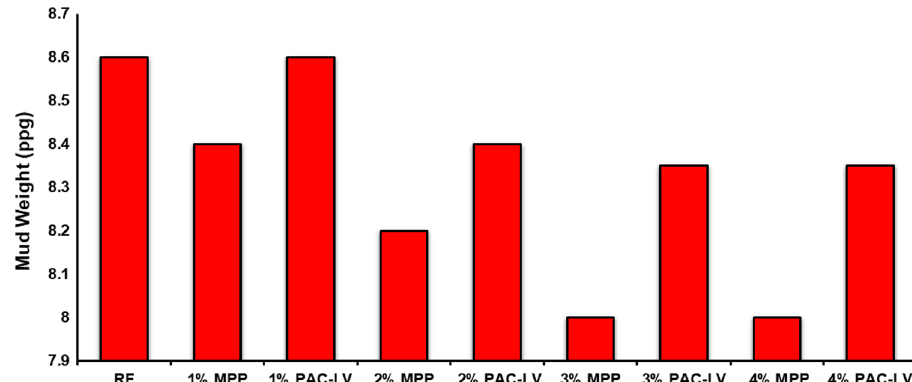
Fig. 9 The effect of MPP and PAC-LV on mud